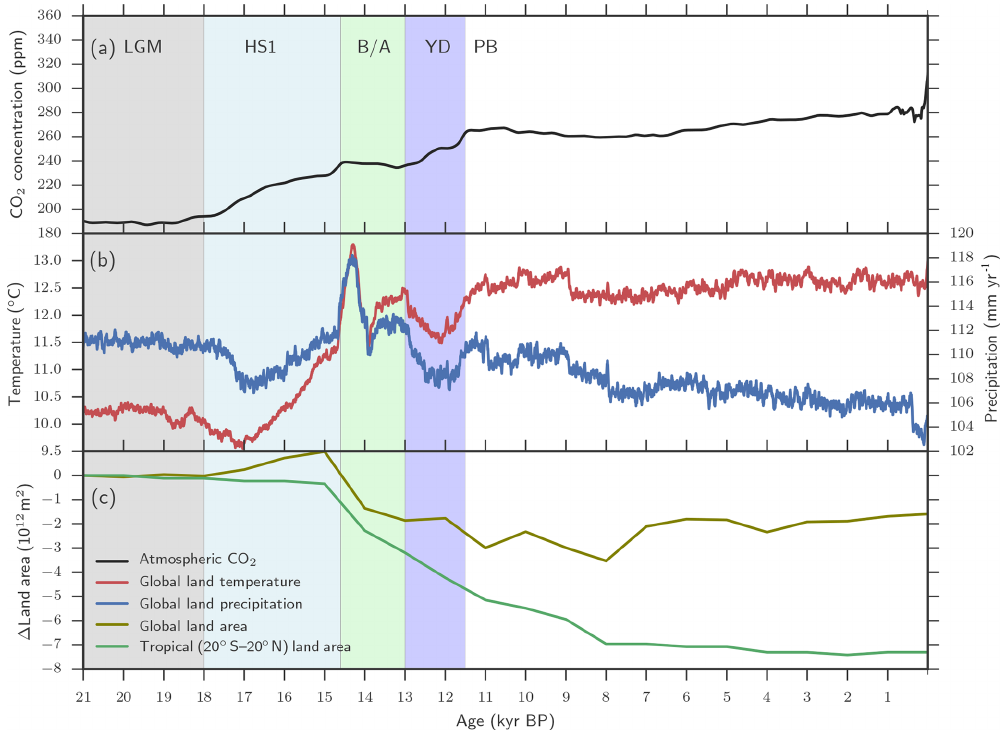
Figure 2. Aggregated LPX-Bern(v1.4N) input data. (a) Evolution of atmospheric CO 2 , (b) of temperature and precipitation, and (c) of changes in tropical and global land as available for plant growth relative to 21ka (bottom). Temperature and precipitation represent mean values over global land areas that were not flooded and not ice-covered at 21kaPB and at